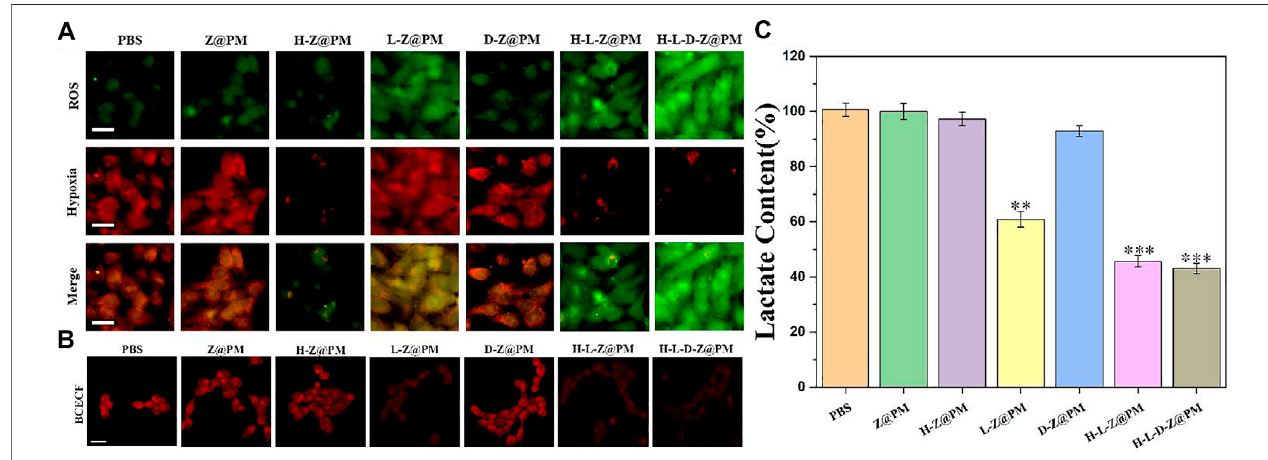
FIGURE4| H-L-D-Z@PM-mediatedgenerationofoxidativestressandslightlyacidicand hypoxic environmentin4T1cells. Fluorescencemicrographsof4T1cells with (A) oxidative stress/hypoxia (Scale bar: 20 µm) and CLSM images of 4T1 cells. (B) pH (scale bar: 20 µm) detection probes in different treatments. (C) Lactate content after incubation with different materials for 24 h ** p < 0.01, *** p <